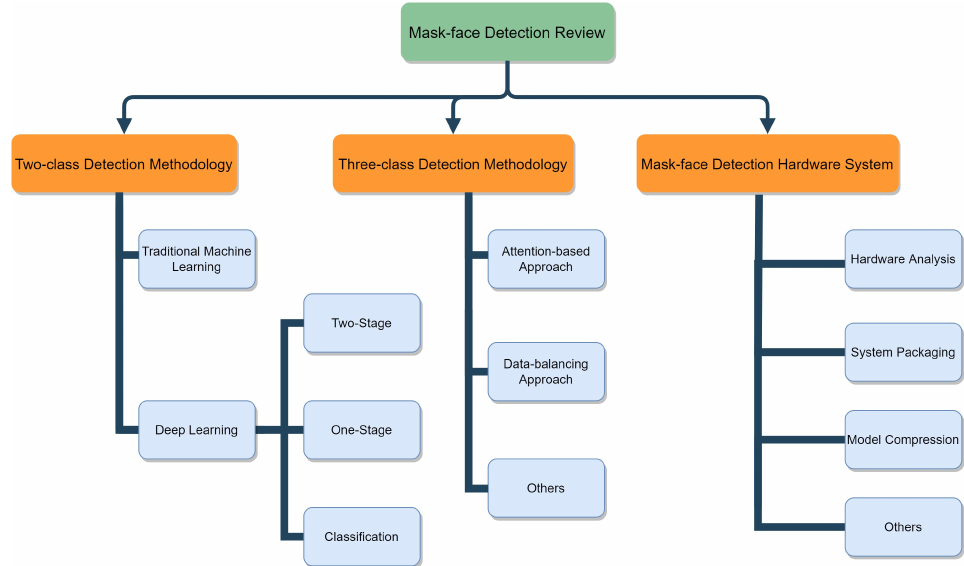
Figure 2. The overall mask-face detection review